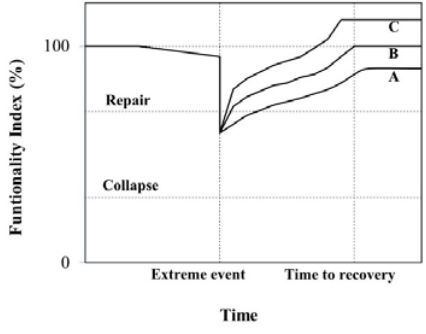
Figure 1. Functionality curve [23].